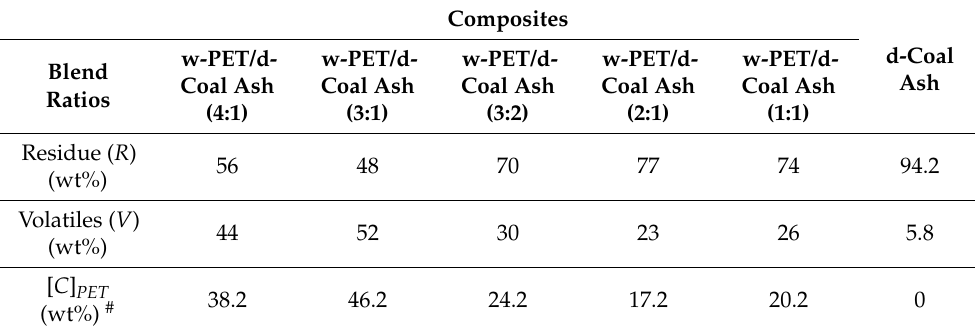
Table 1. Summary of the TGA results (residue yield, volatiles, and fixed carbon) obtained for co-carbonization products derived from different w-PET/d-coal ash composites. Composites d-Coal